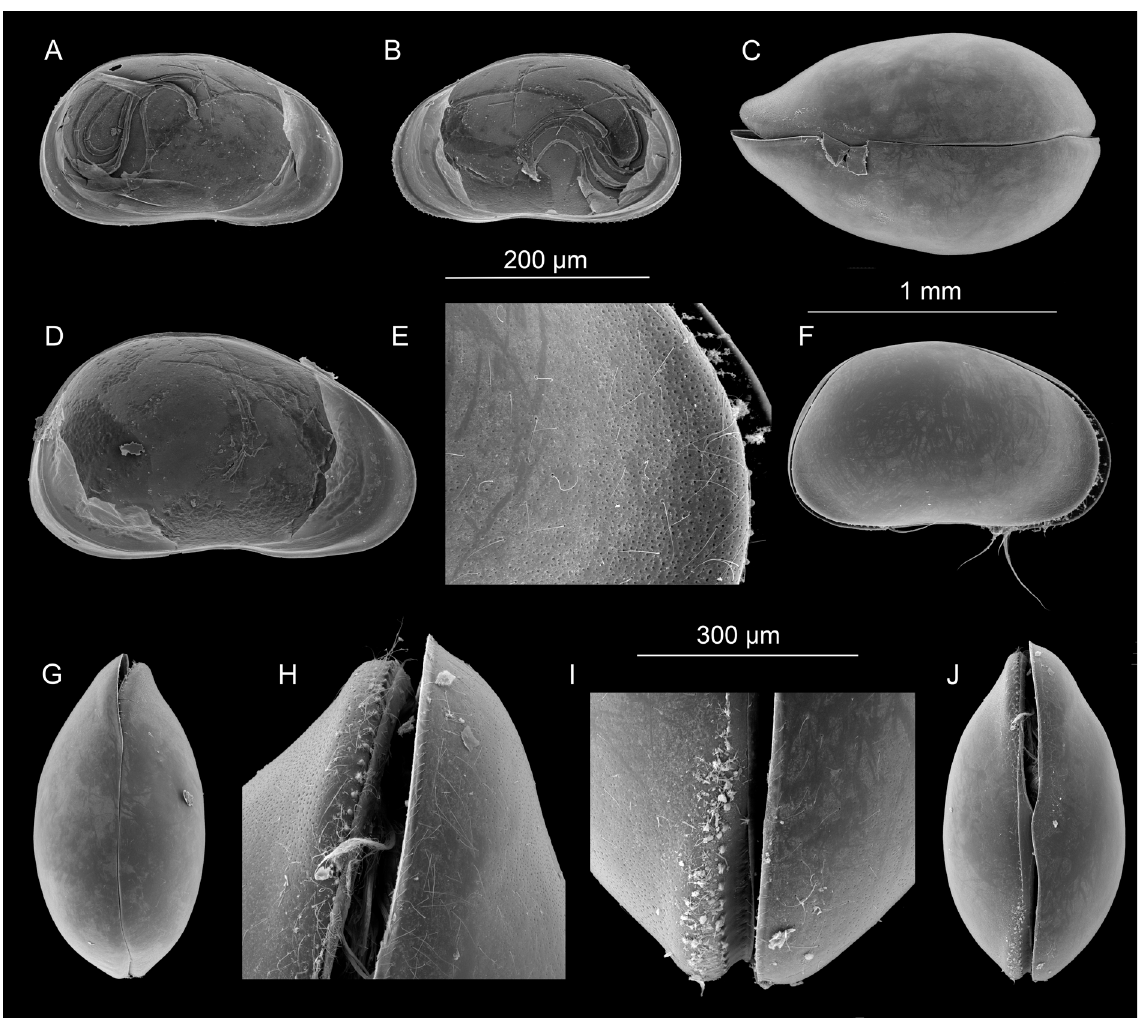
Fig. 6. Trilocypris horwitzi gen. et sp. nov., Lake Austin (type locality). A . LVi, ♂, holotype